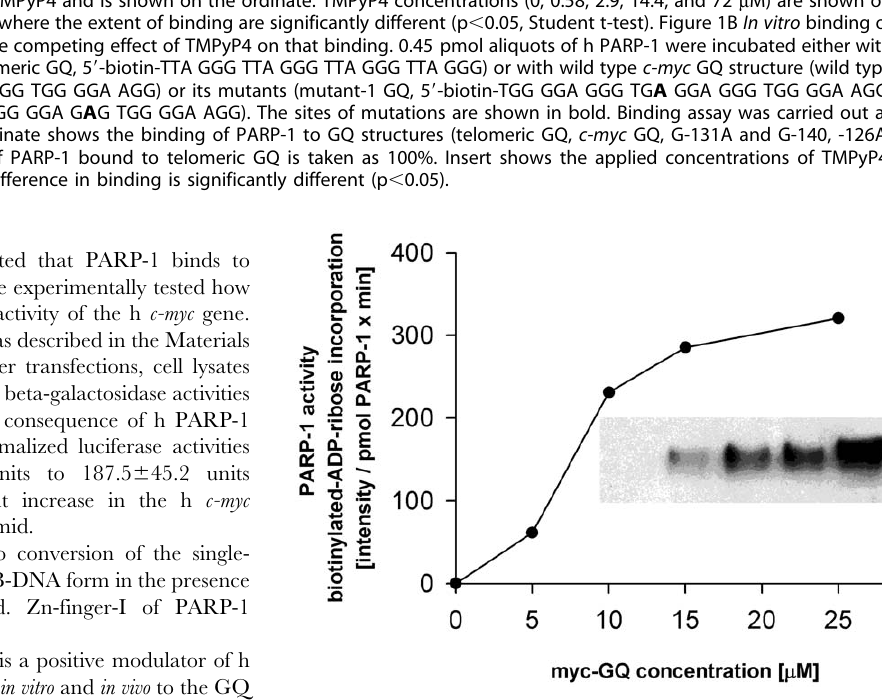
Figure 2. Invitro effect of wild type h c-myc GQ structure on the enzymatic activity of h PARP-1. PARP-1 (1 pmol) was incubated with 6-biotin-17-NAD (75 m M) in the presence of various concentrations of c-myc GQ oligonucleotides for 10 minutes at 23 u C. At the end of incubation an equal volume of Laemmli sample buffer was admixed, boiled samples were electrophoresed (10% SDS-PAGE), and trans- blotted onto nitrocellulose sheet and the aspecific binding sites were blocked by incubating the blot in a solution containing 3% fat free milk dissolved in PBS. This was followed by an incubation of the blot with HPO conjugated streptavidine (1 m g/ml) for an hour. Bound biotin-ADP- ribose was detected by ECL. The fluorogram shown in the insert ( c-myc GQ concentrations used in the assays are from left to right: 0, 5, 10, 15 and 25 m M). Spot intensities were quantitated using a Bio-Rad gel- analyzer system. Ordinate shows the incorporation of biotin-ADP-ribose in pixel intensity/pmol PARP-1 6 min units while the applied GQ concentrations are shown on the abscissa. One representative experiment is shown from three independent experiments.